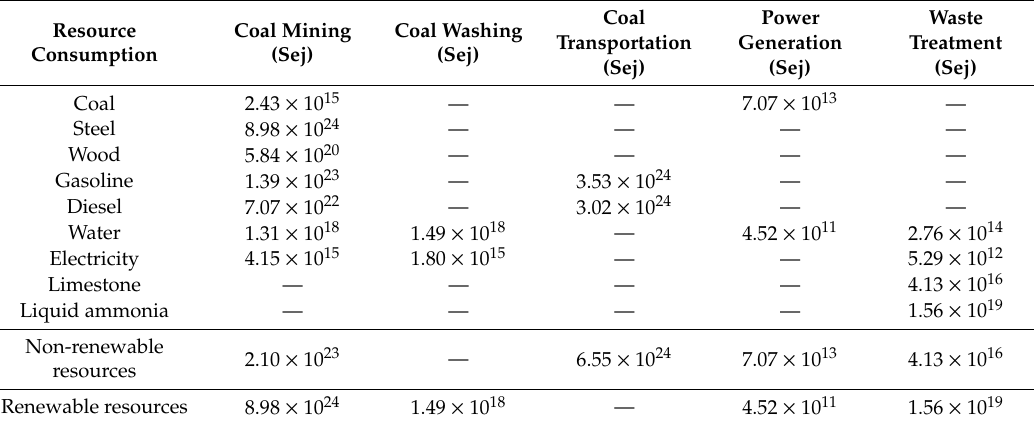
Table 6. Life cycle resource consumption of Unit 2.